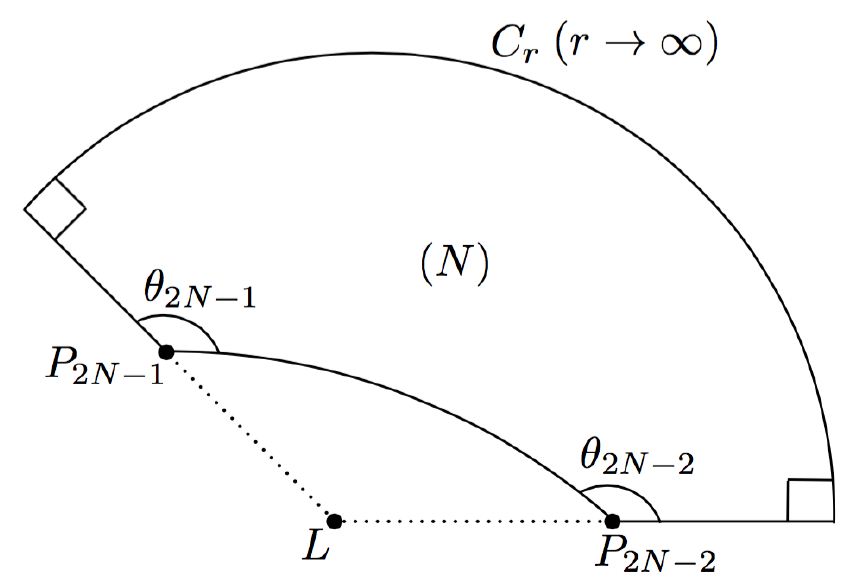
Figure 8. A quadrilateral in any loop number: This case is discussed when we prove by induction that Equation (7) holds in any loop